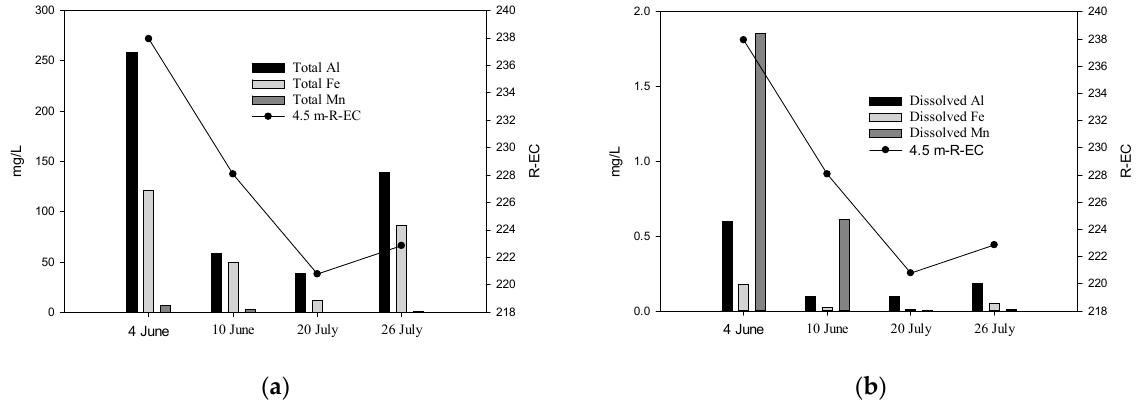
Figure 5. Changes in water quality at 4.5 m. ( a ) Changes in total heavy metal concentrations and ( b ) changes in dissolved heavy metal concentrations.